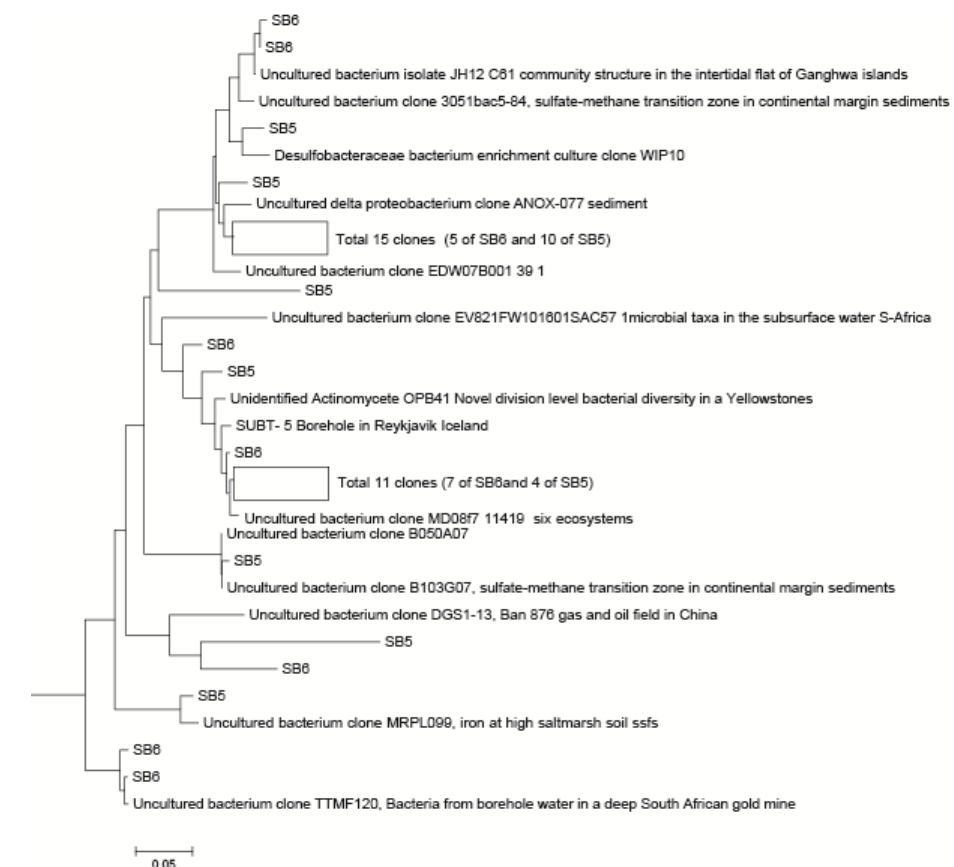
Figure 6. Neighbour-joining tree of sequences from the 16S rRNA clone libraries, databases showing phylogenetic relationships. The scale bar represents the expected percentage of substitutions per nucleotide position, and a marine Crenarchaeon was used as outgroup. The cluster in uncultured delta Proteobacterium clone ANOX-077 represents 11 clones with 99% sequence similarity (5 SB6 and 10 SB5 from the borehole). The cluster in uncultured bacterium clone MD08f7 11 clones with 99% sequence similarity (7 SB6 and 5 SB5 from the